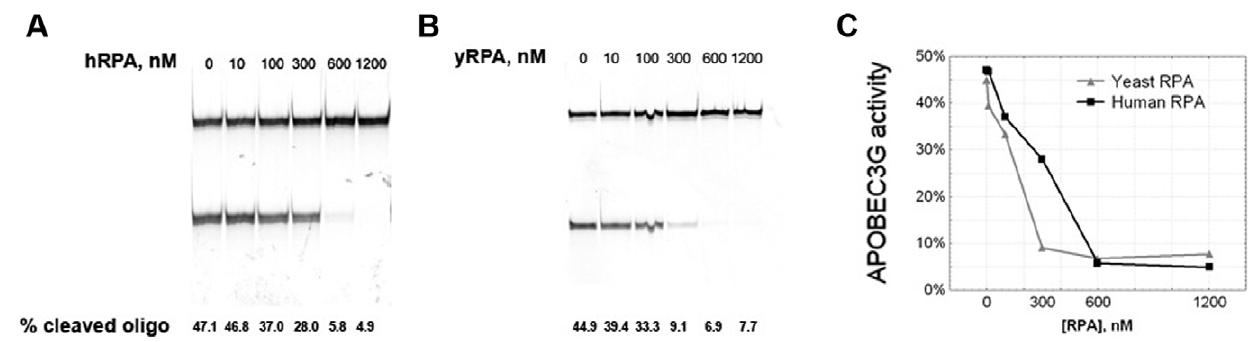
Figure 6. RPA inhibits deaminase activity of A3G invitro . Oligonucleotide deamination assay (Materials and Methods and Fig. 5b) was performed with the addition of human (a) and yeast (b) RPA in various concentrations. Relative deaminase activity was calculated as a percentage of cleaved oligo. Activity data for A3G in the presence of human and yeast RPA were plotted as a function of RPA concentration (c).